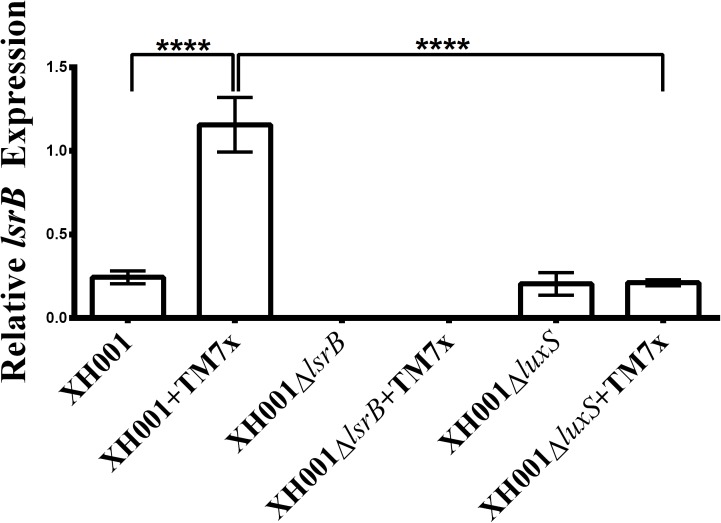
Quantification of lsrB expression. lsrB expression levels were monitored and each bar represents the average of two independent cultures performed in triplicate (error bars, SD). Significance is indicated when p < 0.0001 with four asterisks. Statistical analysis was performed using the Student’s t-test (two-tailed).